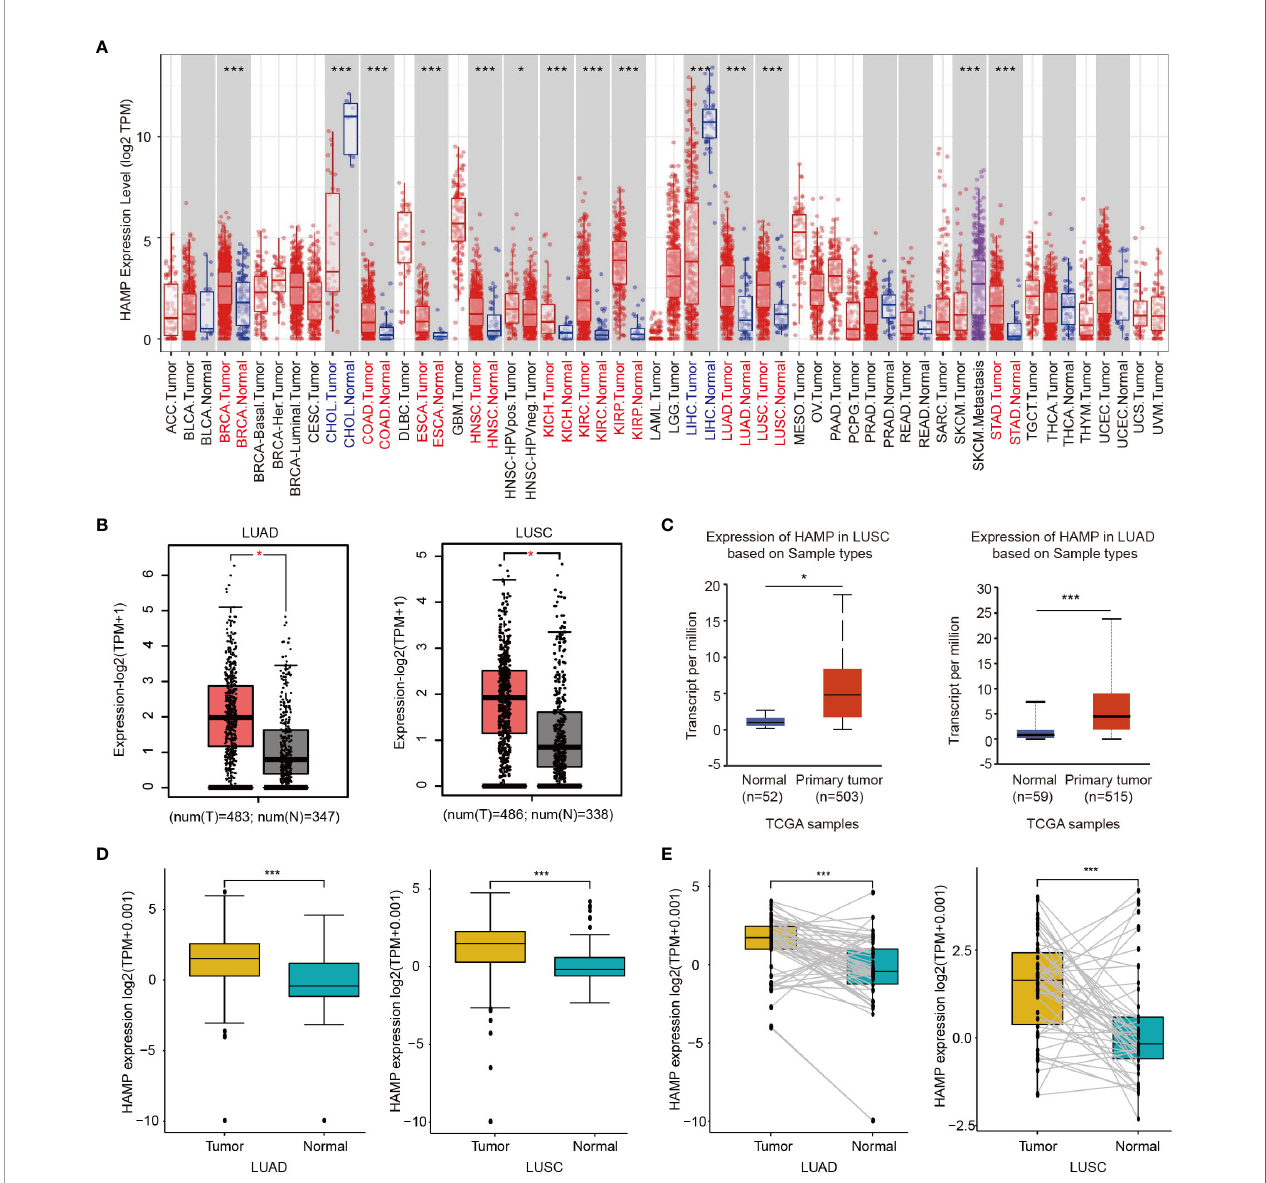
FIGURE 1 | Expression of hepcidin in lung cancer. (A) Hepcidin expression in different types of cancer was investigated with the TIMER database. (B) Increased or decreased expression of hepcidin in lung cancer compared to normal tissues in the GEPIA database. (C) Hepcidin expression in lung cancer was examined by using the UALCAN database. (D) Analysis of hepcidin expression in lung cancer and adjacent normal tissues in the TCGA database. (E) TCGA database and statistical analyses of hepcidin expression in 58 pairs of LUAD tissues and adjacent normal tissues and 50 pairs of LUSC tissues and adjacent normal tissues, respectively. *p < 0.05, ***p <